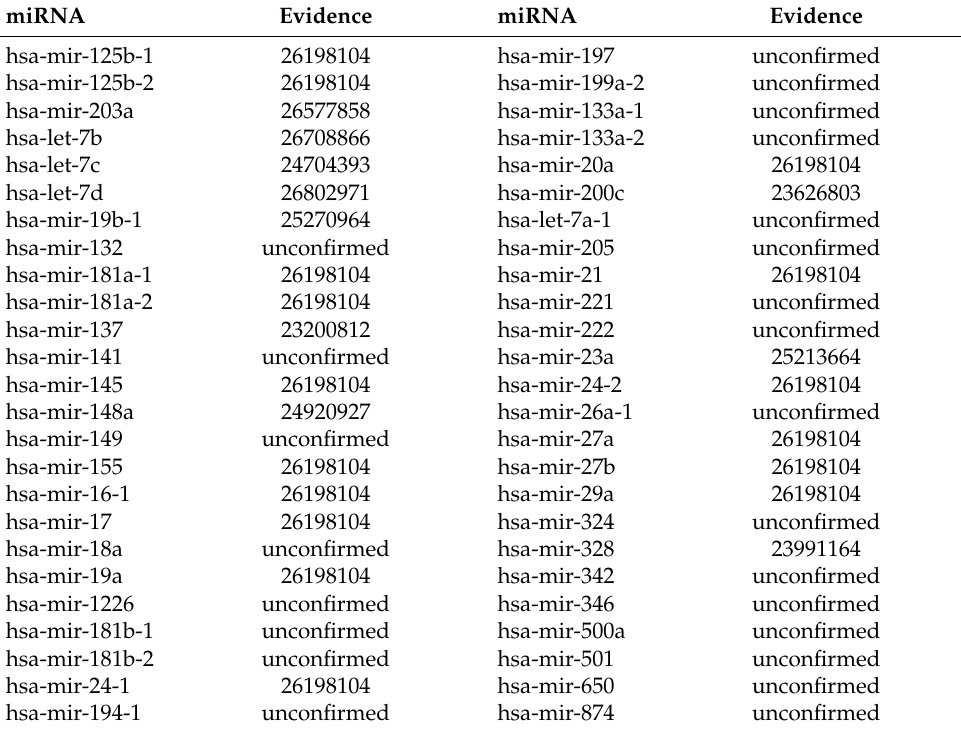
Table 8. The top 50 SM–miRNA associations predicted by AMCSMMA in the second type of case study to the SM 5-Aza-2’-deoxycytidine.